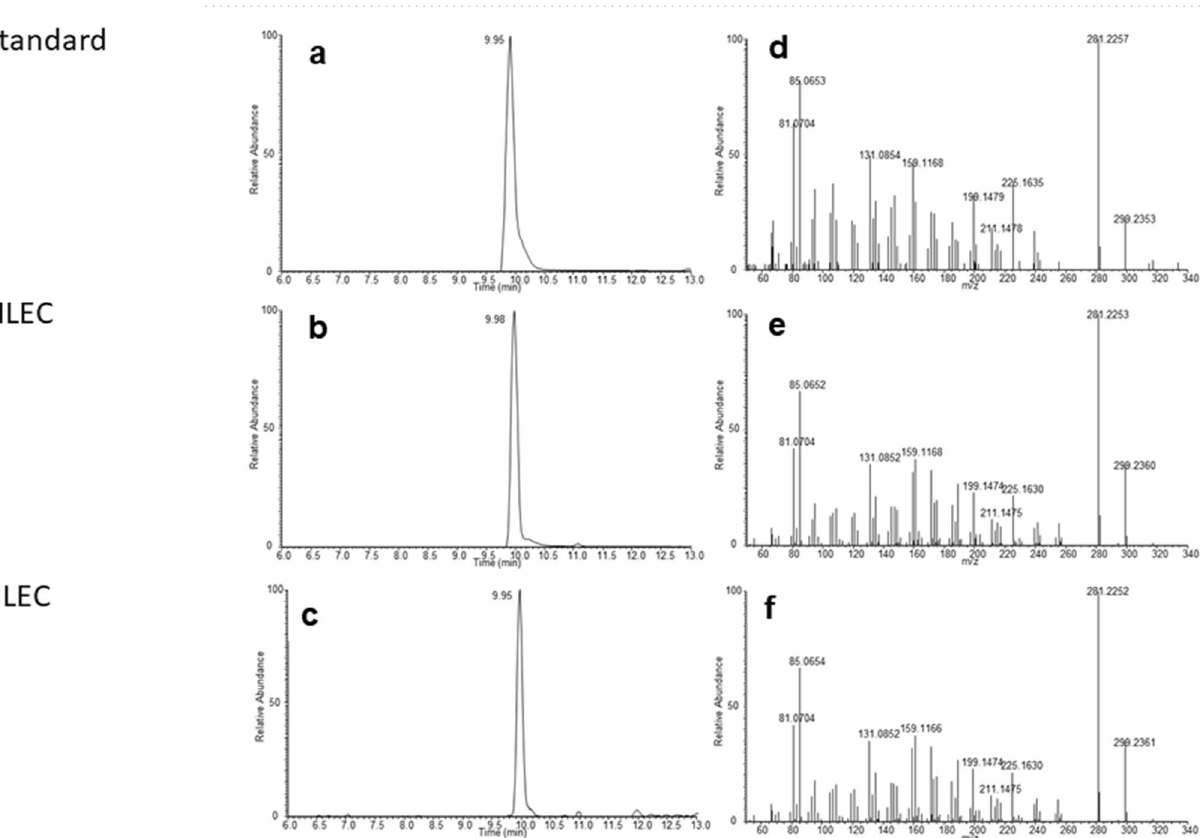
Figure 3. Identification of 6α-OH-pregnanolone by LC–MS/MS in HLEC and dLEC cells. LC–MS trace of m/z 317.2469 corresponding to a sum formula of C 21 H 34 O 3 in an authentic standard ( a ), in HLEC cells ( b ) and in dLEC cells ( c ). MS/MS fragment spectra recorded at LC–MS peak maximum in an authentic standard ( d ), in HLEC cells ( e ) and in dLEC cells ( f